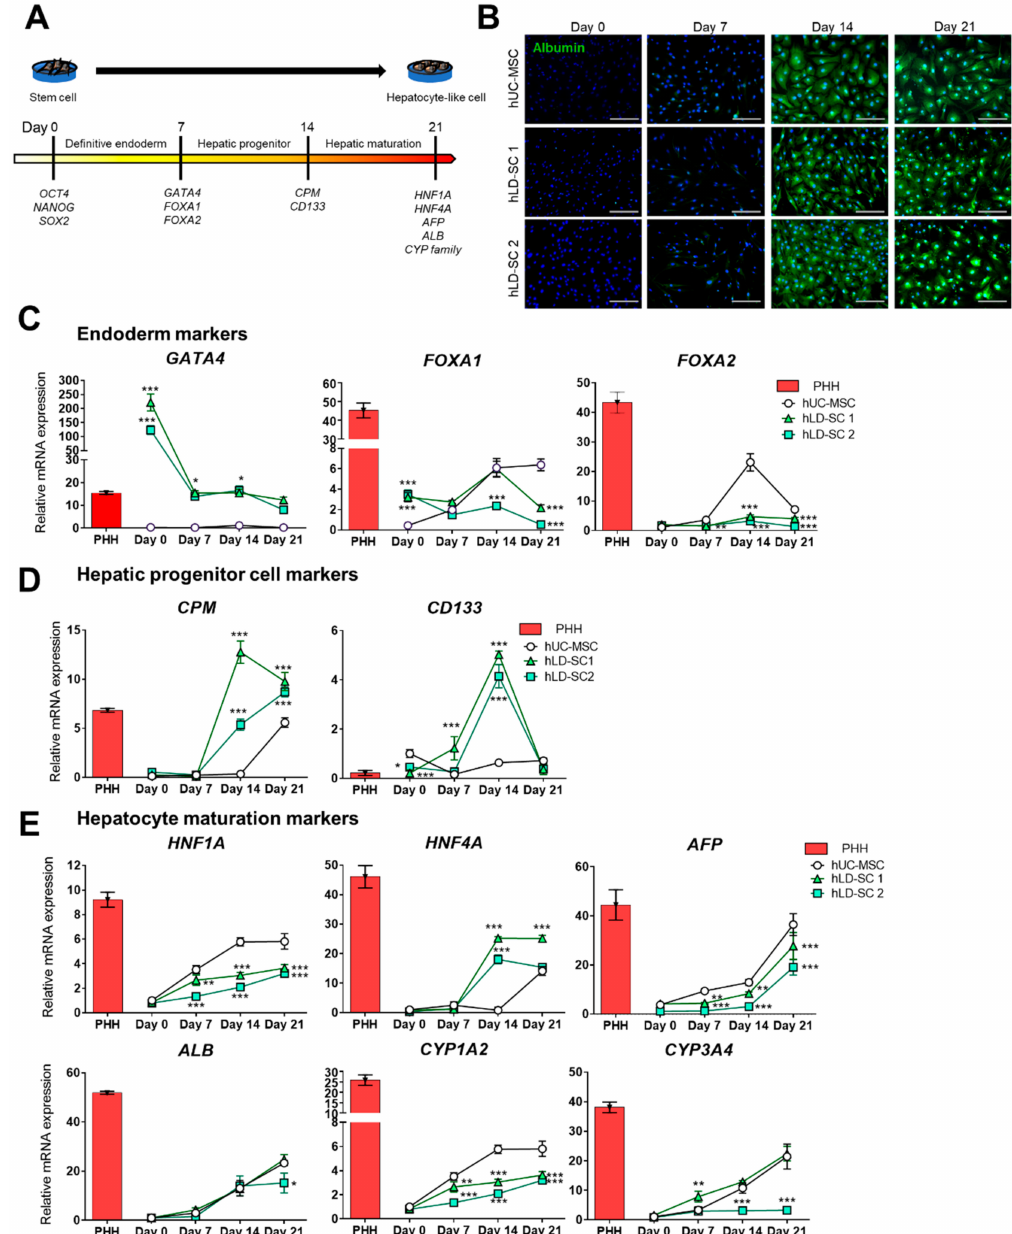
Figure 3. Expression of genes related to the di ff erentiation of stem cells towards hepatic fate. ( A ) Schematic diagram of the di ff erentiation of stem cells towards hepatic fate. The prominent genes during di ff erentiation are described. ( B ) Albumin immunofluorescence staining of hUC-MSCs and two hLD-SCs on days 0, 7, 14, and 21 of di ff erentiation. Blue, DAPI; Green, albumin. Scale bar, 200 µ m. qRT-PCR measurement of ( C ) endodermal markers ( GATA4 , FOXA1 , and FOXA2 ), ( D ) hepatic progenitor markers ( CPM and CD133 ), and ( E ) hepatocyte maturation markers ( HNF1A , HNF4A , AFP , ALB , CYP1A2 , and CYP3A4 ). Expression levels were normalized to GAPDH and compared to the expression levels of hUC-MSCs on di ff erentiation day 0. Two-way analysis of variance (ANOVA) was used, and P -values of hLD-SCs were compared to those of hUC-MSCs on di ff erentiation days 0, 7, 14, and 21. P -values < 0.05 were considered significant. n = 4. *, p < 0.05; **, p < 0.01; ***, p <